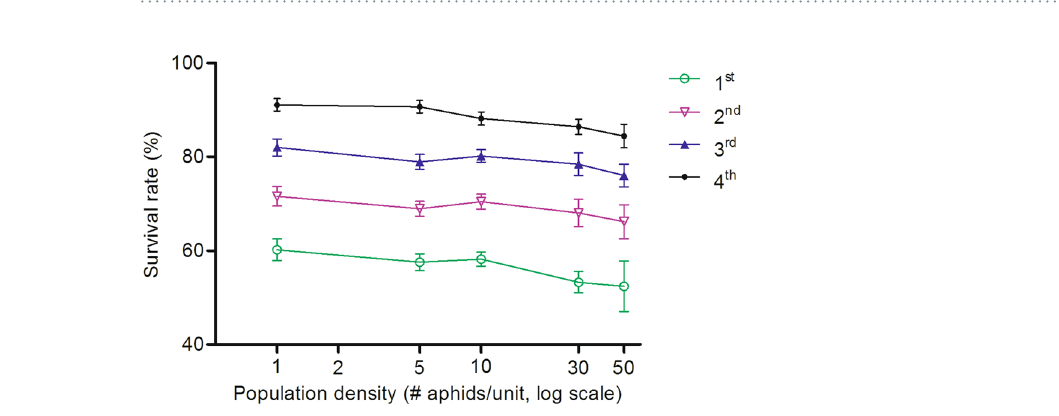
Figure 1. Survivorship (mean ± SE%) of Rhopalosiphum maidis at each developmental stage with different population densities under 22